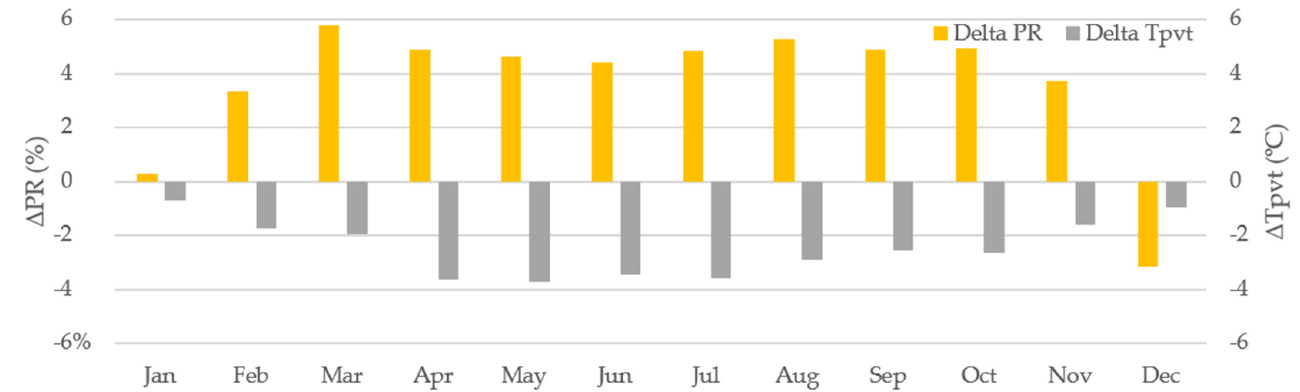
Figure 17. Monthly average daily PR and operation temperature relation between PVT and PVT.